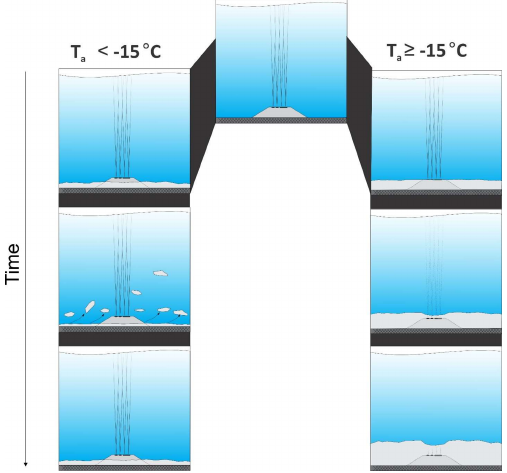
Figure 9. Schematic illustrations of impacts on SWIPS profiling of the proposed anchor ice layer evolution mechanism (with time advancing downward) under alternatively soft ( T a ≥ − 15 ◦ C) and hard ( T a < − 15 ◦ C) supercooling